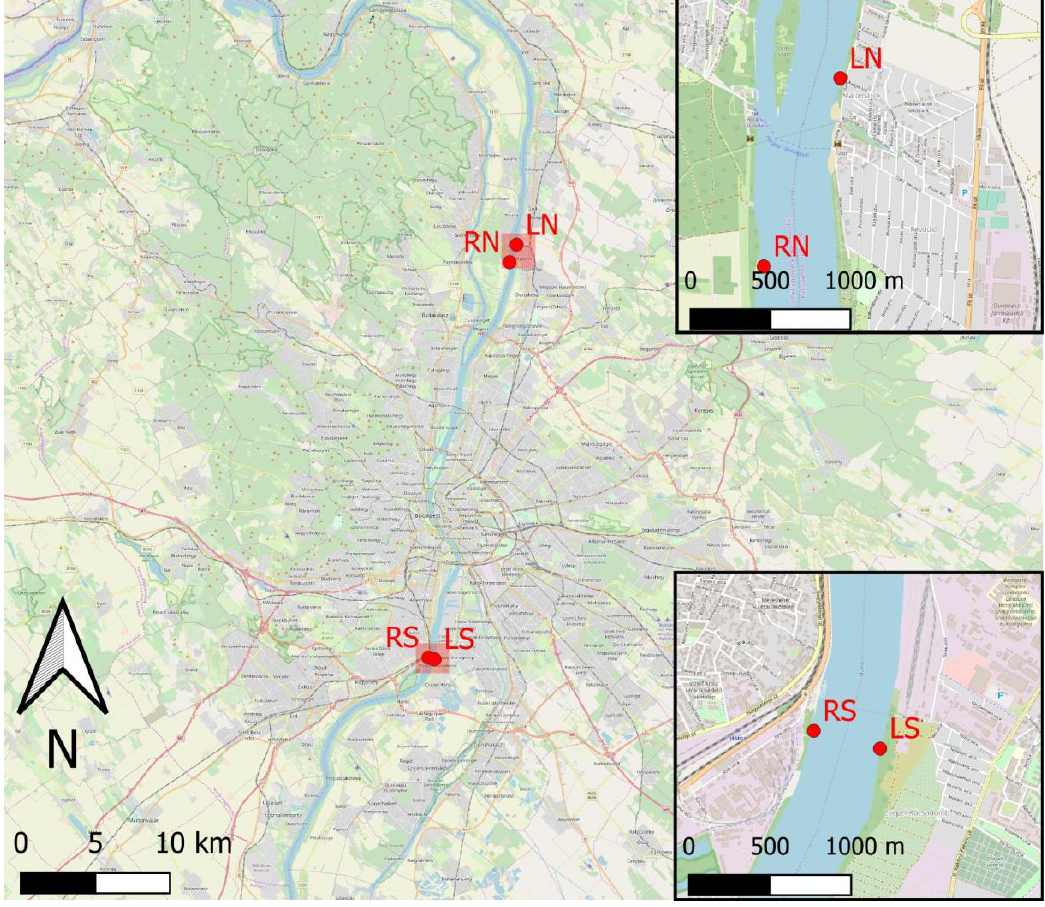
Figure 1. Map illustrating the location of sampling points. Markings: RN = upstream of Budapest, right bank; LN = upstream, left bank; RS = downstream, right bank; LS = downstream, left bank. The